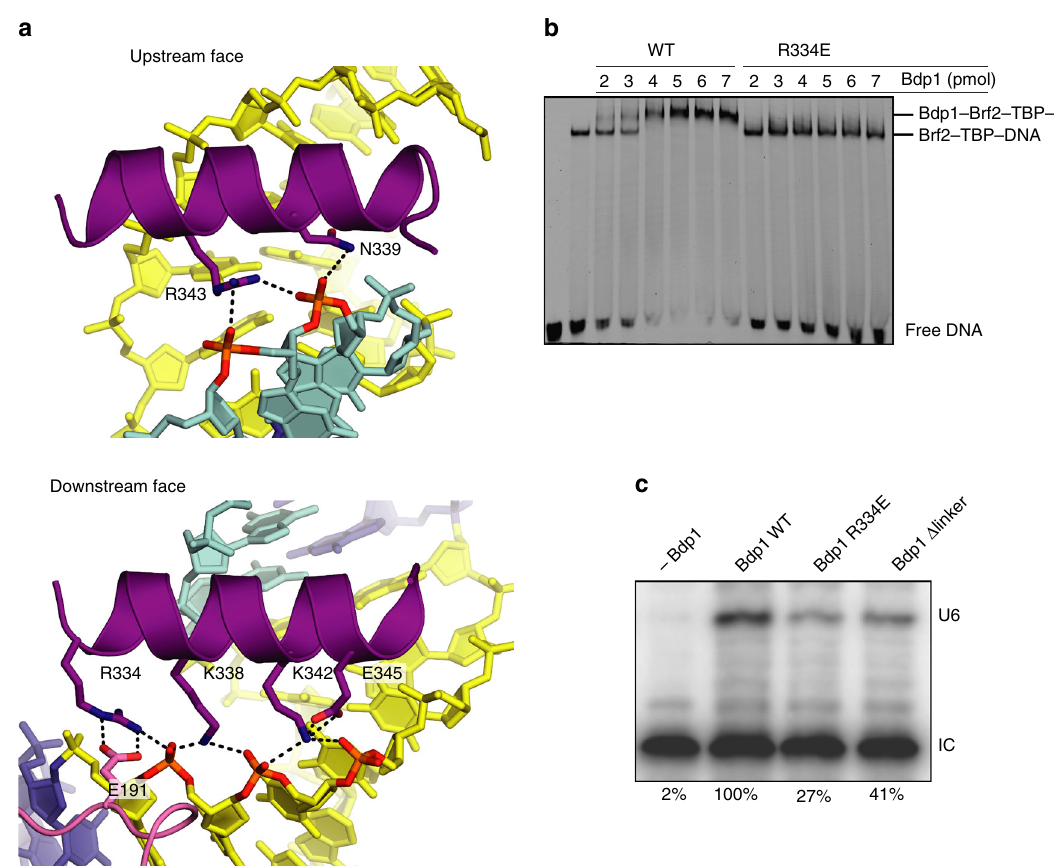
Fig. 3 Interactions of the SANT domain of Bdp1 with DNA and TBP. a The recognition helix of the Bdp1 SANT domain interacts with both faces of the major grove of the DNA through conserved polar interactions. Bdp1 R334 forms a strong salt bridge with TBP E191. b EMSA showing reduced binding of Bdp1 R334E mutant to Brf2 – TBP – DNA complexes. c A Bdp1 R334E mutation reduces U6 transcription in vitro. IC is the internal loading control. The values at the bottom represent the % of the normalized intensities relative to the wild-type Bdp1 sample. The IC band was used for